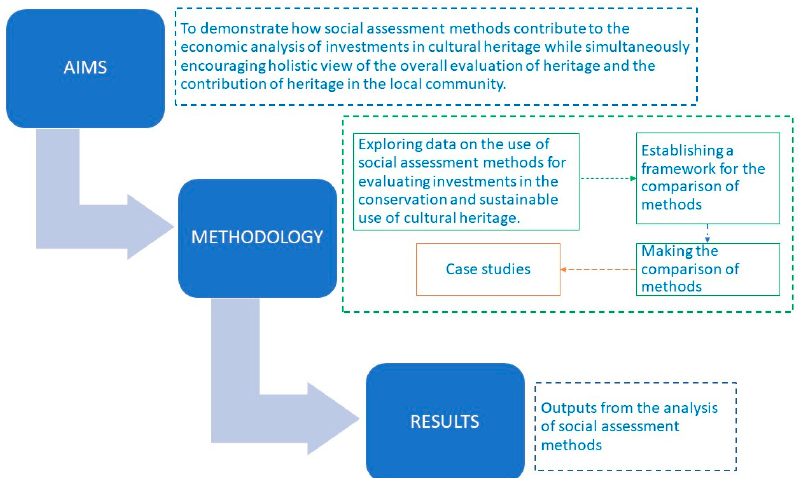
Figure 1. A flow diagram outlining the aims − methodology − results path. Source: Authors.